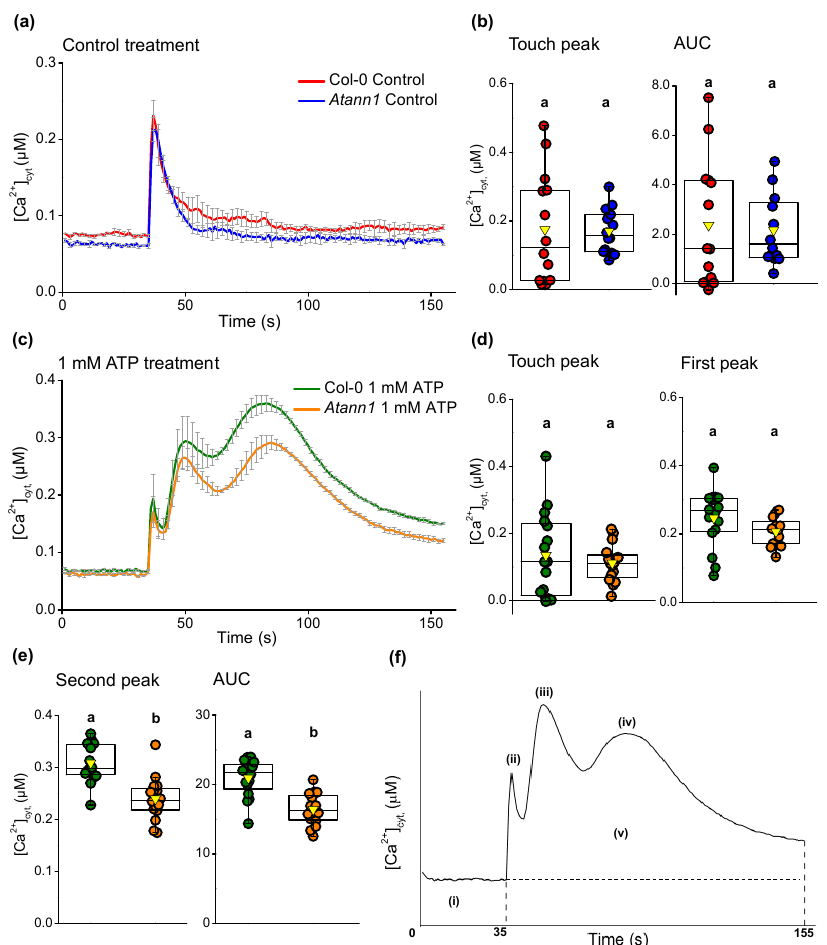
Figure 1. Arabidopsis annexin 1 (AtANN1) is needed for normal [Ca 2+ ] cyt elevation in a root by eATP. ( a ) Time course of [Ca 2+ ] cyt elevation produced by control treatment in three experiments (mean (± SEM): Col-0 in red, n = 14 roots in total; Atann1 loss of function mutant in blue, n = 14). ( b ) The [Ca 2+ ] cyt touch peak values and area under the curve (AUC) extracted from the control time course (± SEM). Middle line of the boxplot represents the median whereas the inverted triangle represents the mean. ( c ) Time course of [Ca 2+ ] cyt elevation with 1 mM eATP treatment in 3 experiments (Col-0 in green, n = 16; Atann1 in orange, n = 16). ( d ) The touch peak and the first peak [Ca 2+ ] cyt values extracted from the 1 mM eATP time course. ( e ) Second peak and the AUC [Ca 2+ ] cyt values. ( f ) Schematic diagram of different time course sections. Each section was calculated with the average baseline value (indicated by (i)) subtracted. Touch peak (ii) was the highest [Ca 2+ ] cyt value of the touch response between 35 and 40 s due to mechanical stimulus from solution addition at the 35th second. First peak (iii) and second peak (iv) were the highest [Ca 2+ ] cyt value between 40 s and 60 s and 60 s and 155 s, respectively. Total [Ca 2+ ] cyt accumulation was obtained from the AUC (v; 35 s–155 s). p -values were obtained from analysis of variance (ANOVA) with Tukey’s post-hoc test or Kruskal–Wallis test for non-parametric approaches. Different lower-case letters indicate a significant difference between means ( p < 0.05).